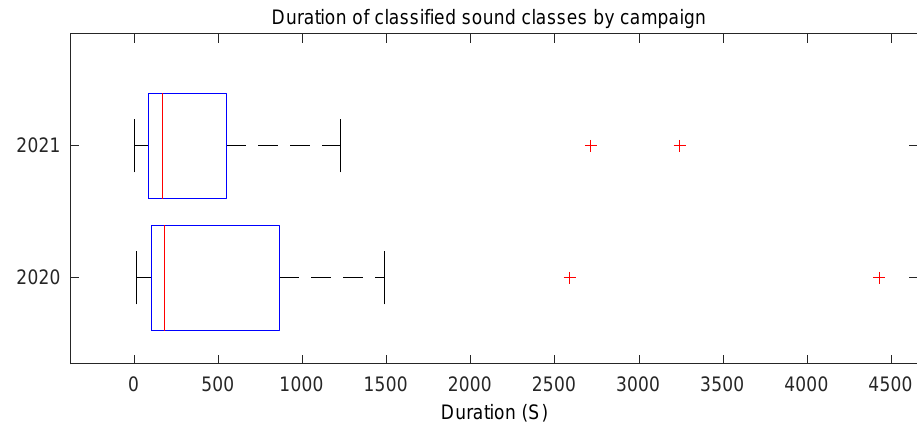
Figure 6. Comparative between 2020 and 2021’s aggregated duration of the sound categories.